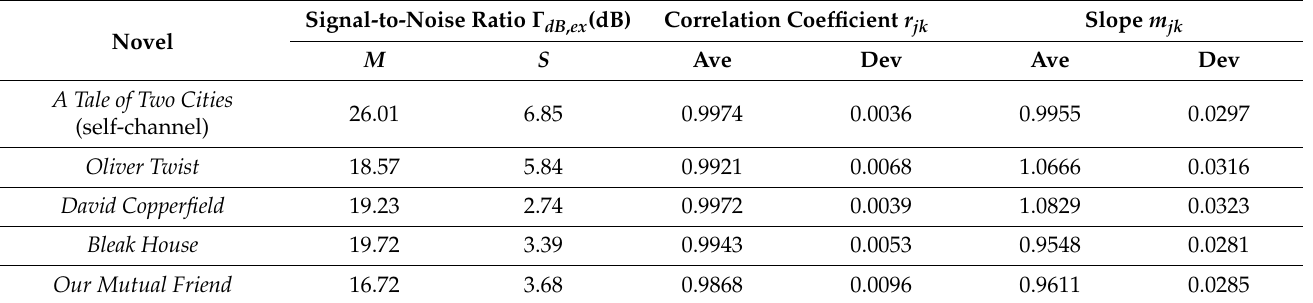
Table 8. Average value M (dB) and standard deviation S (dB) of Γ dB , ex (dB) in self- and cross-channels, correlation coefficient r jk , and slope m jk of the regression line between the number of sentences n S of A Tale of Two Cities (channel output, self-channel) versus the number of sentences n S in the other Dickens novels (channel input, cross-channels), for equal number of words, in the sentences channel.